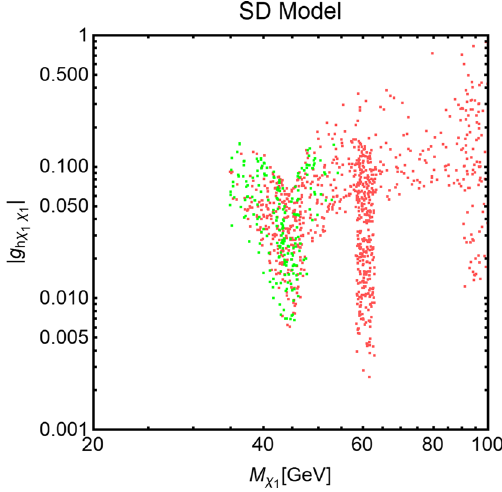
, c ] plane with an invis- H χ 1 χ 1 1